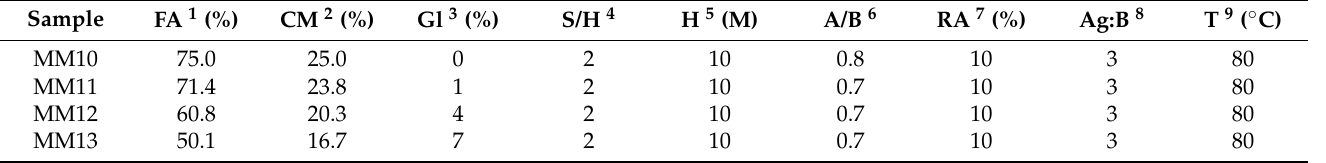
Table 8. Key material ratios of the mortar mixtures—first approach. Sample